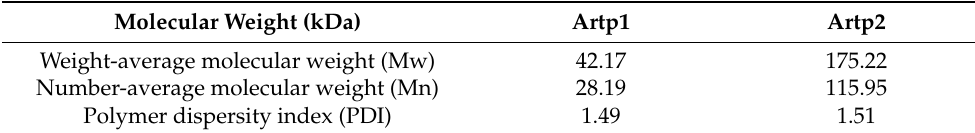
Table 2. The molecular weights of Artp1 and